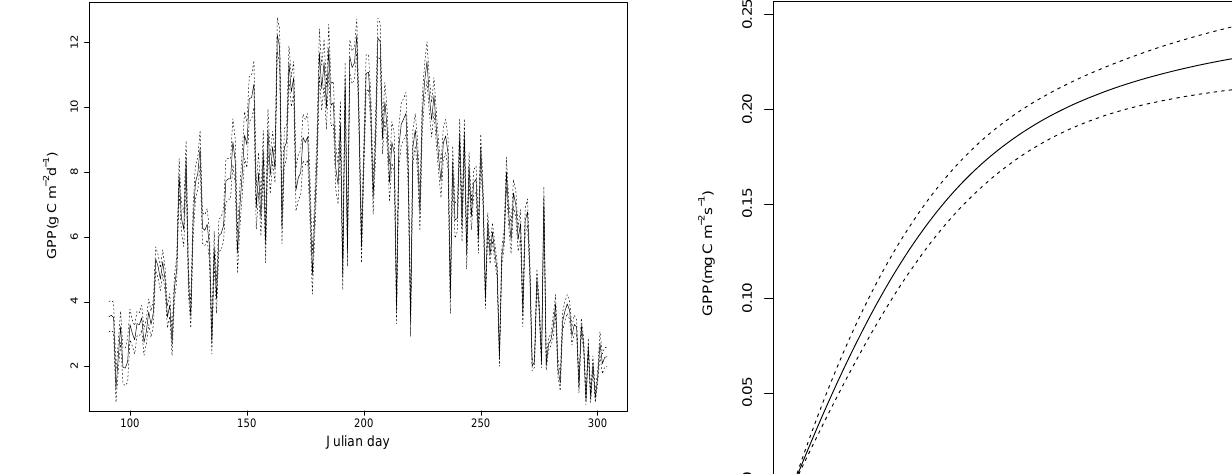
Figure 4. Median (solid line) and 95% credible intervals (dashed lines) of daily GPP distributions during the growing season of 2009 (1 April to 31 October 2009, Julian days 91 to 304) for the choice of informative prior distributions.